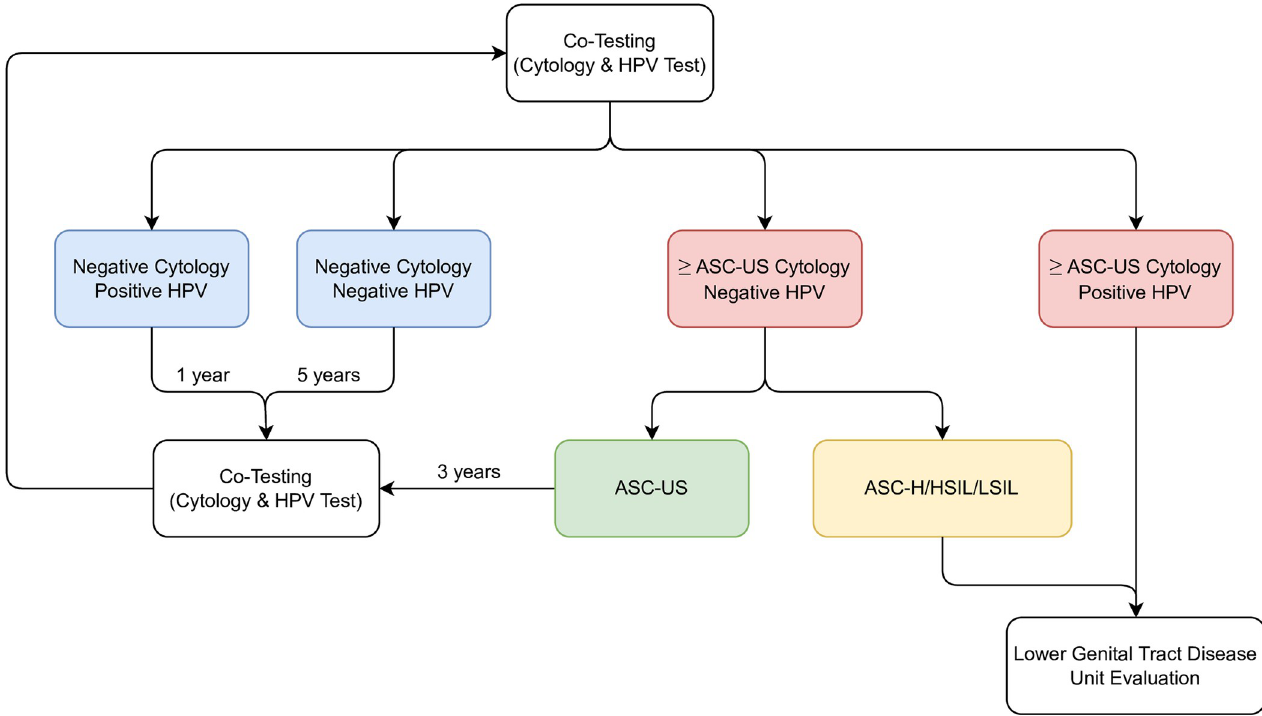
Fig 2. Cervical cancer screening algorithm via co-testing. The molecular test has an international cost of USD$250. The evaluations that include the clinical time and reagents are equivalent to 12% of the value: Lower Genital Tract Disease Unit Evaluation USD$4 (2%), Cytology USD$4 (2%), Colposcopy USD$2 (0.8%), Biopsy USD$10 (4%), Tissue processing and analysis USD$11 (4%). The costs of "clinical interventions" were not considered because, in our country, they are negligible in comparison to molecular methods. Code used: Human Papillomavirus (HPV); Atypical squamous cells, which cannot exclude a high- grade squamous intraepithelial lesion (ASC-H); Atypical Squamous Cells of Undetermined Significance (ASC-US); High-Grade Squamous Intraepithelial Lesion (HSIL); Low-Grade Squamous Intraepithelial Lesion (LSIL); Atypical Glandular Cells (AGC); Adenocarcinoma In Situ (AIS).